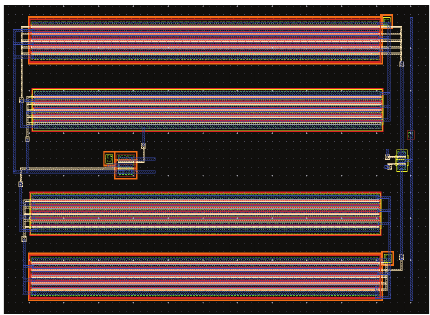
Figure 6: Layout of the proposed ULPD-DCVSL structure.